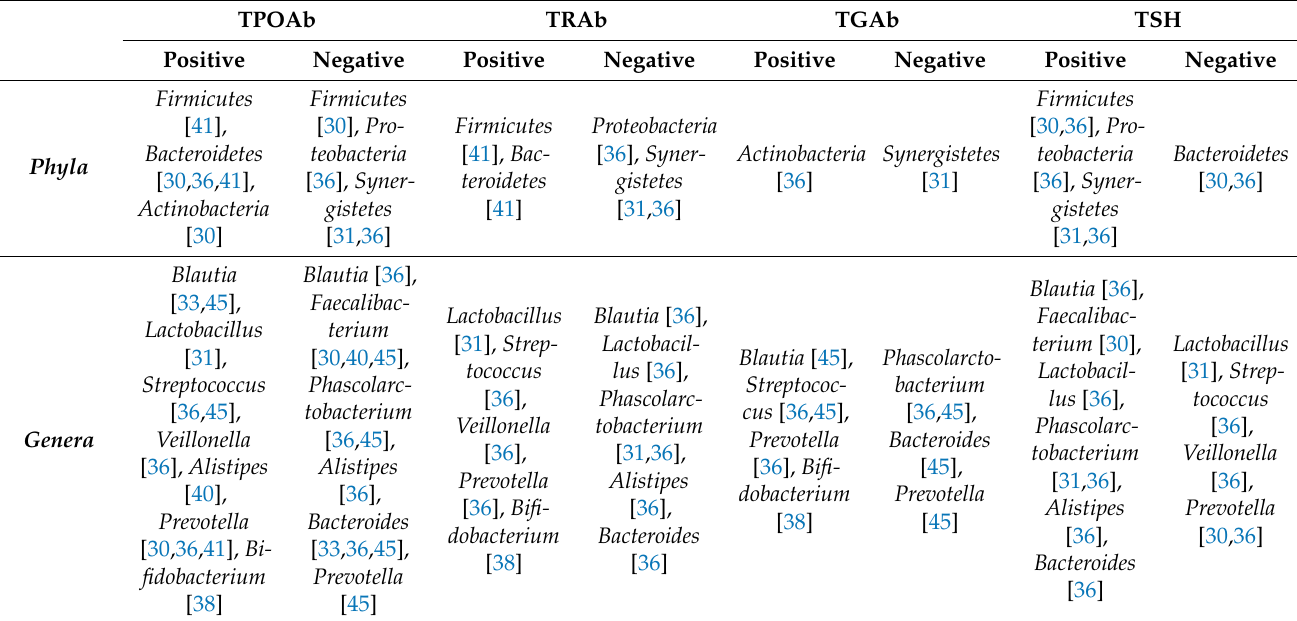
Table 5. Significant correlations between microbiota alterations with the thyroid functional parame- ters